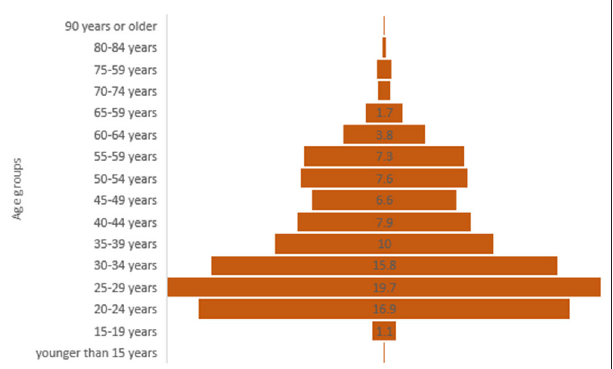
FIGURE 2 | Distribution of age groups within the study population indicated in percent ( n =